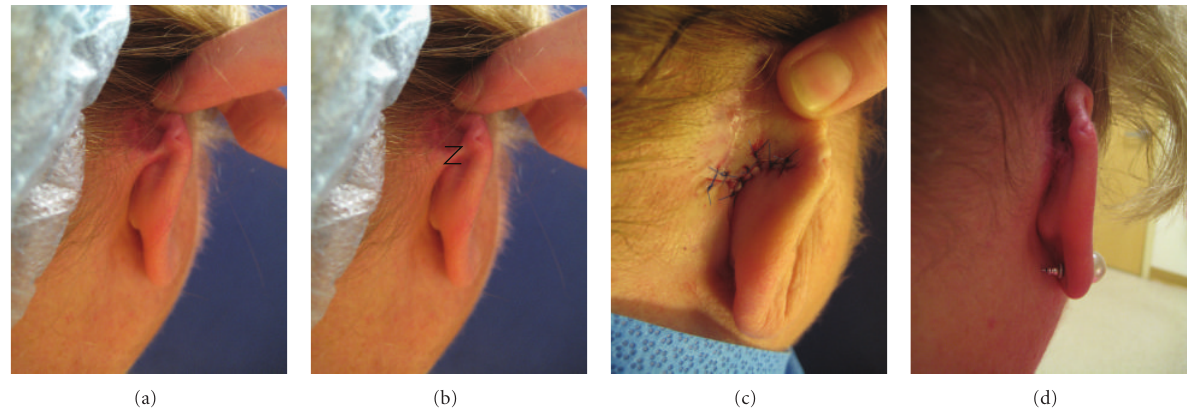
Figure 6: (a) Scar creating webbing in the retroauricular sulcus. (b) Z-plasty designed. (c) A Z-plasty is performed to release the contracture. (d) Patient at suture